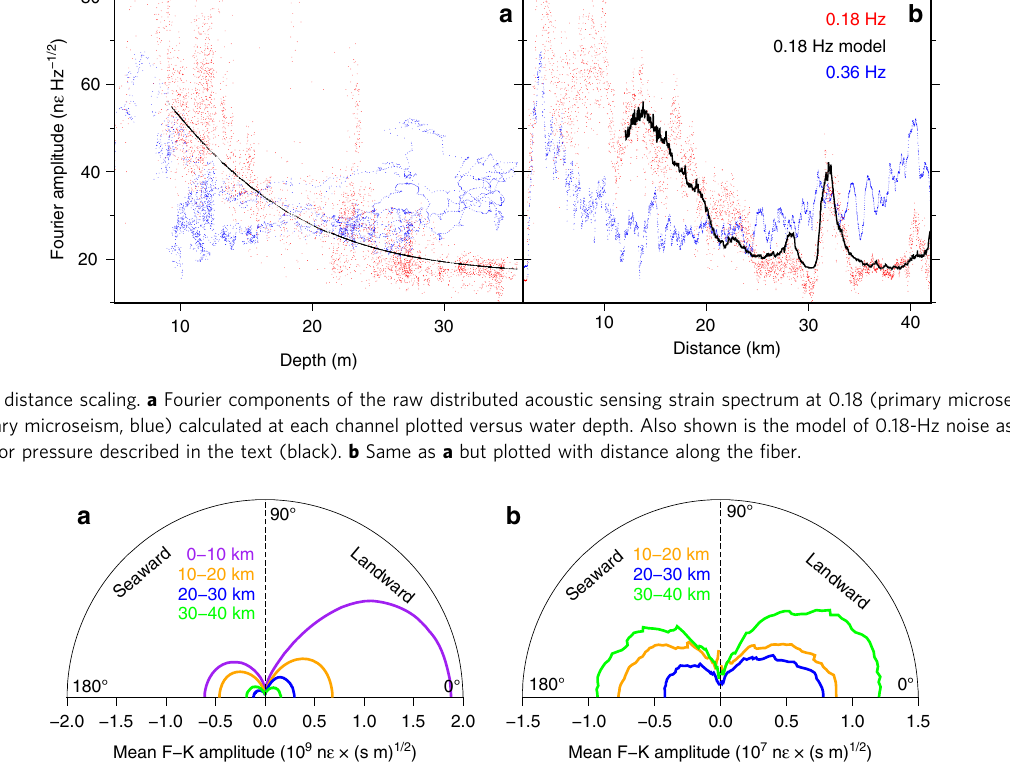
Fig. 7 Directional spectra. a Mean frequency – wavenumber ( f - k ) amplitude of ocean waves (primary microseism) as a function of azimuth calculated between 0.05 and 0.25 Hz using the ocean surface gravity wave dispersion relation for each of the four 10-km array segments. b Mean f - k amplitude of Scholte waves (secondary microseism) as a function of azimuth calculated between 1.5 and 3.5 Hz assuming a true phase velocity of 300 m/s and no dispersion across this frequency